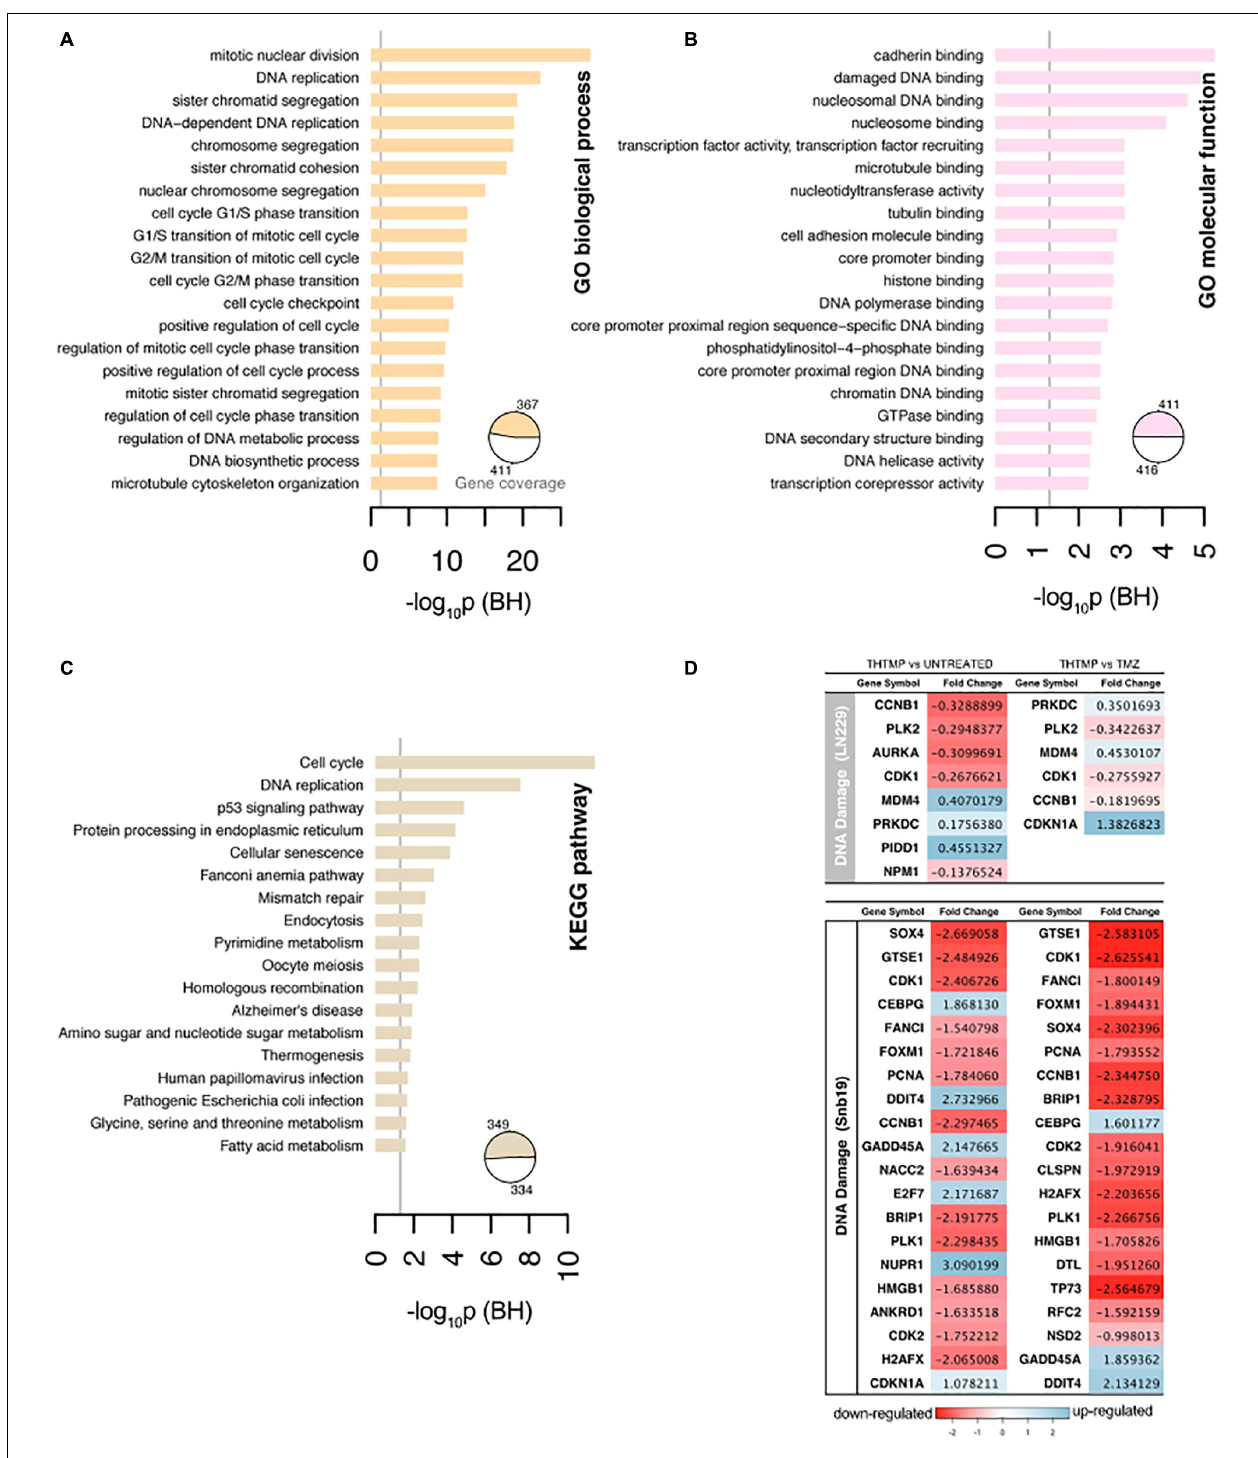
FIGURE 4 | Selected results of Gene Ontology terms and pathways over-representation analysis (FDR < 0.01) on the top 20 terms. (A) Overrepresented Gene Ontology (GO) Biological process terms. (B) Overrepresented GO Molecular function terms. (C) Overrepresented KEGG pathway terms. The x-axis contains the number of genes involved in a particular pathway that were found differentially expressed in our study. The pie charts indicate the fraction of the signature genes associated with significantly enriched terms. The number of genes were normalized to allow comparisons between groups within the same cell line, and the vertical line on the pathways corresponds to the significant p -values. (D) The top 20 DEGs which are involved in the DNA damage on LN229 and Snb19. The DEGs were color coded, with the colors corresponding to the up- and down- expressed.